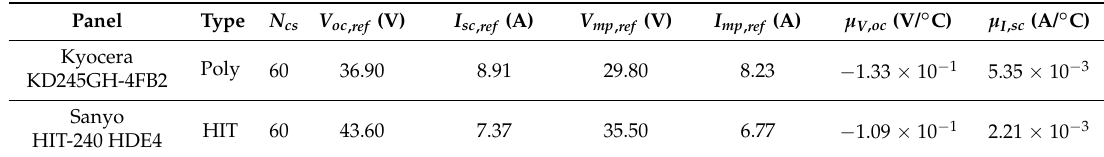
Table 2. Performance data of the simulated PV panels.